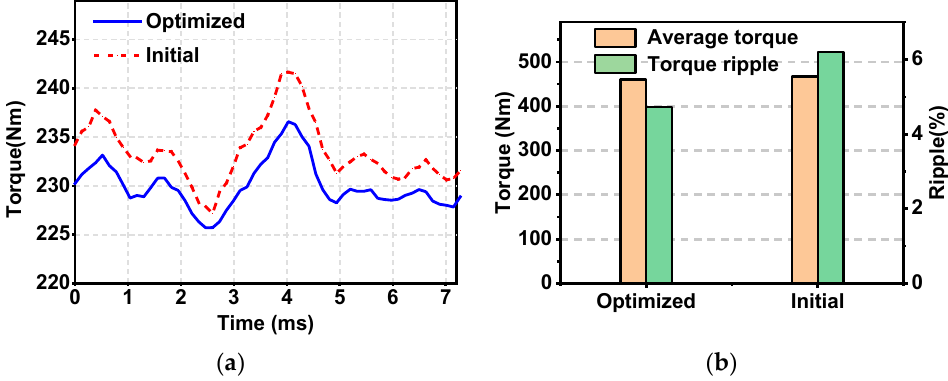
Figure 9. The output torque of SCM-AFPM motors. ( a ) The output torque curve and ( b ) the com-